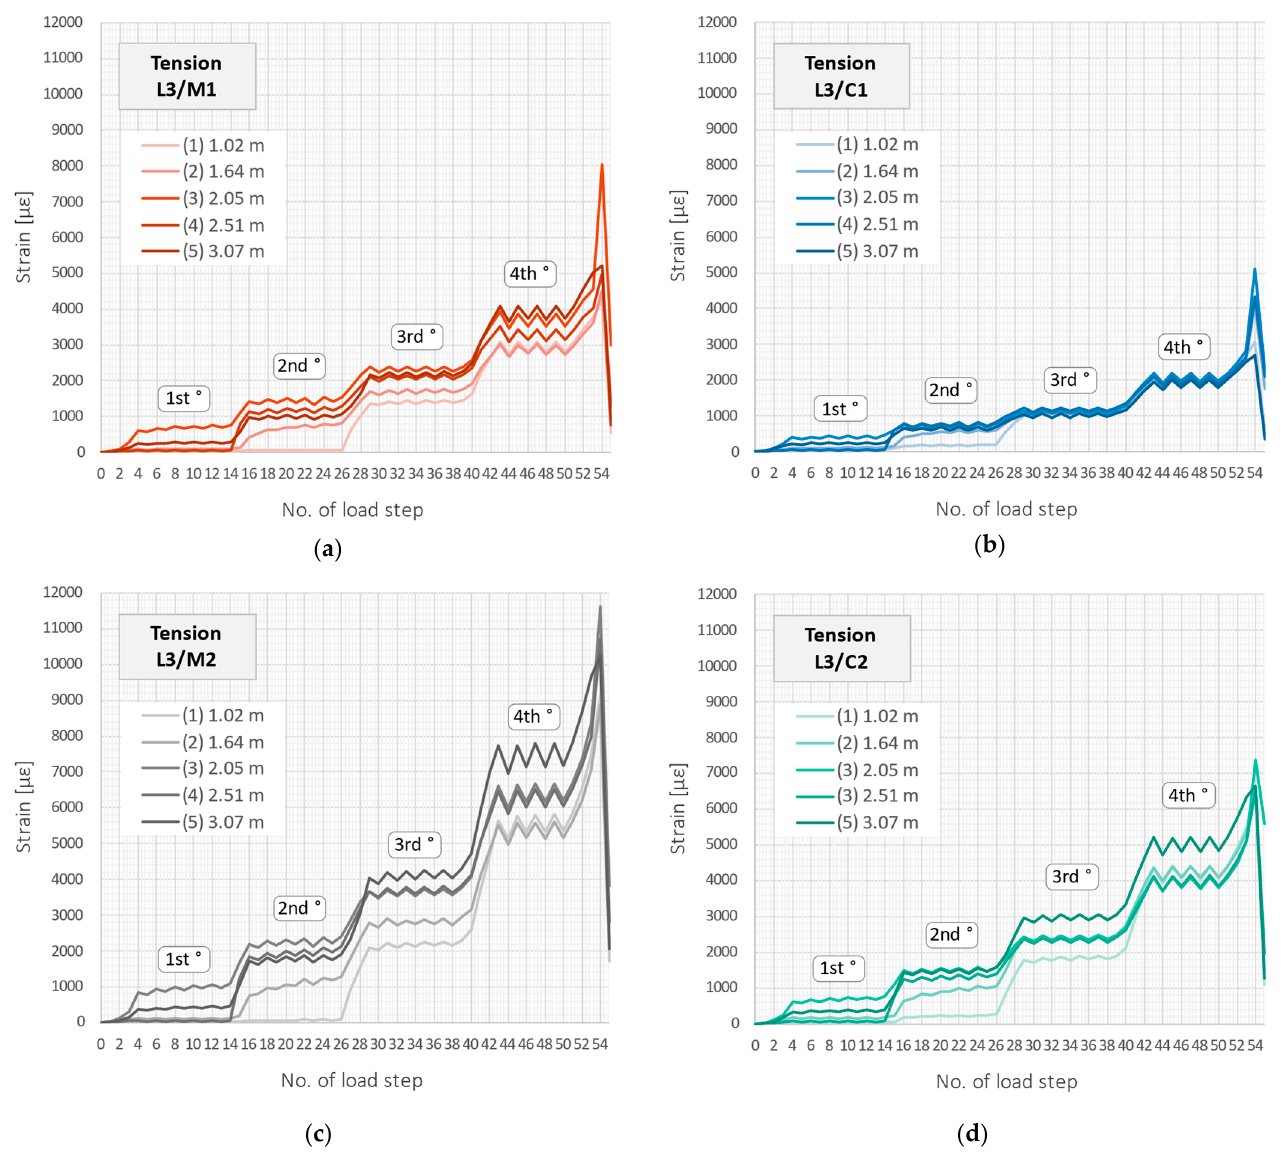
Figure 23. Beam L3/tension zone: crack-induced strain peaks over subsequent load steps registered by the following DFOS tools: ( a ) M1; ( b ) C1; ( c ) M2; ( d ) C2.